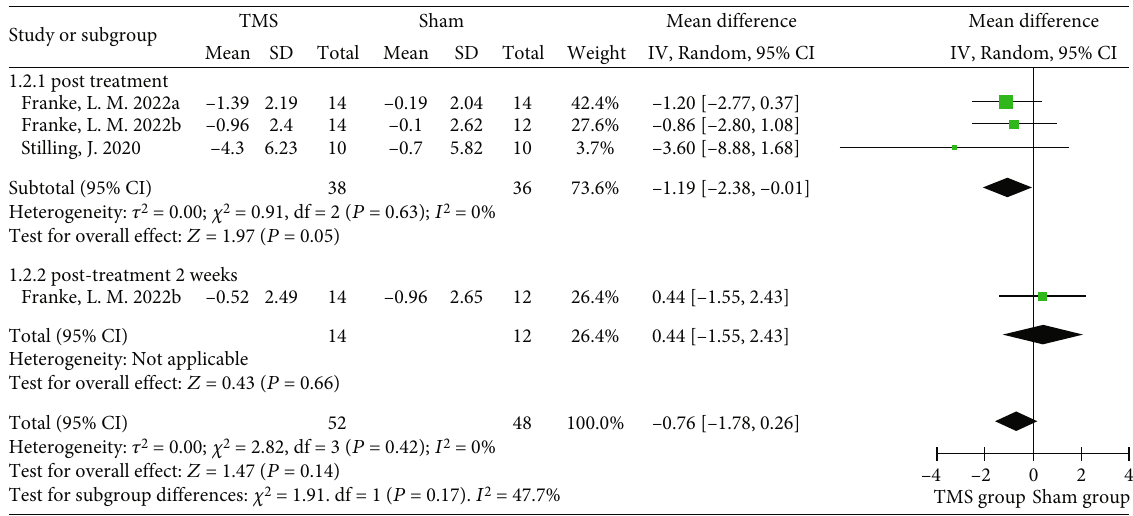
Figure 6: Forest plots of di ff erent-term e ff ects of rTMS on depression measured by the PHQ-9 in TBI patients. PHQ-9: Patient Health